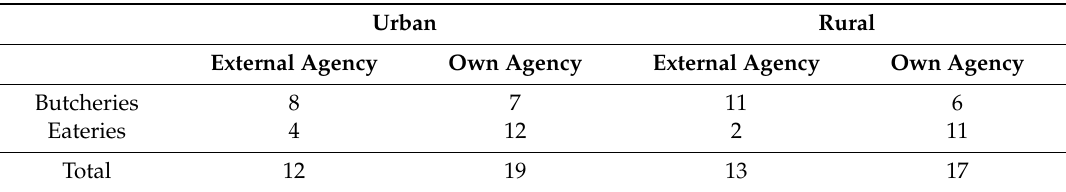
Table 1. Number of times agency was mentioned to explain the prevention of major events with meat safety 1) 2)